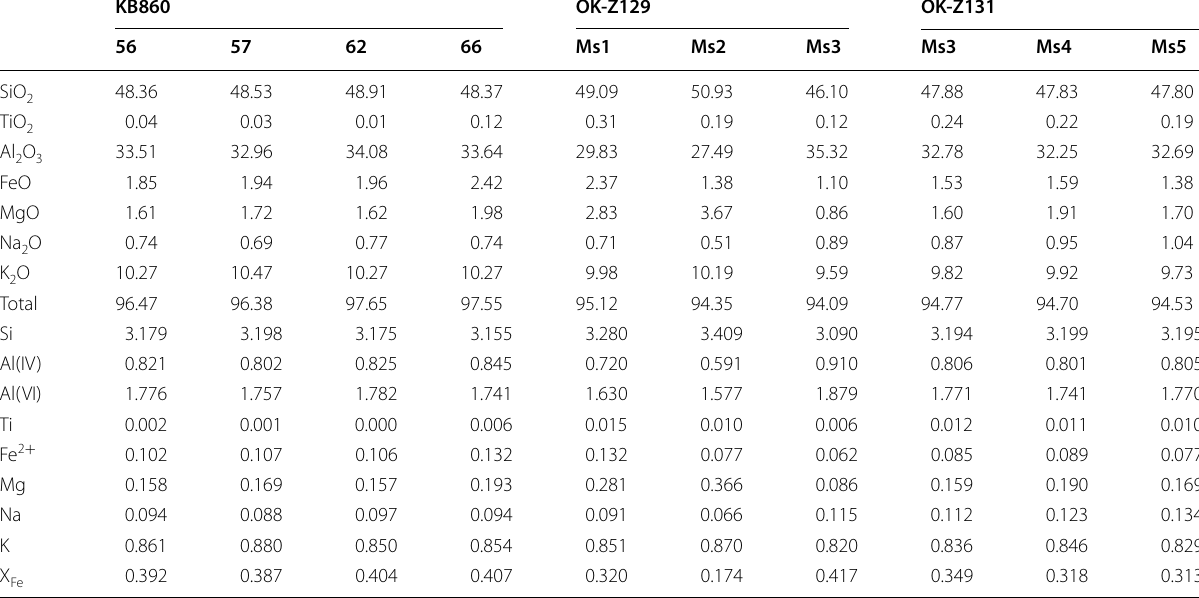
Traces of Cr 2 O 3 , MnO and CaO (< 0.1 wt% each), mineral formulas normalized to 11 oxygen Table 10 Composition of chlorite from four samples of TGU Grt‑Ph schist